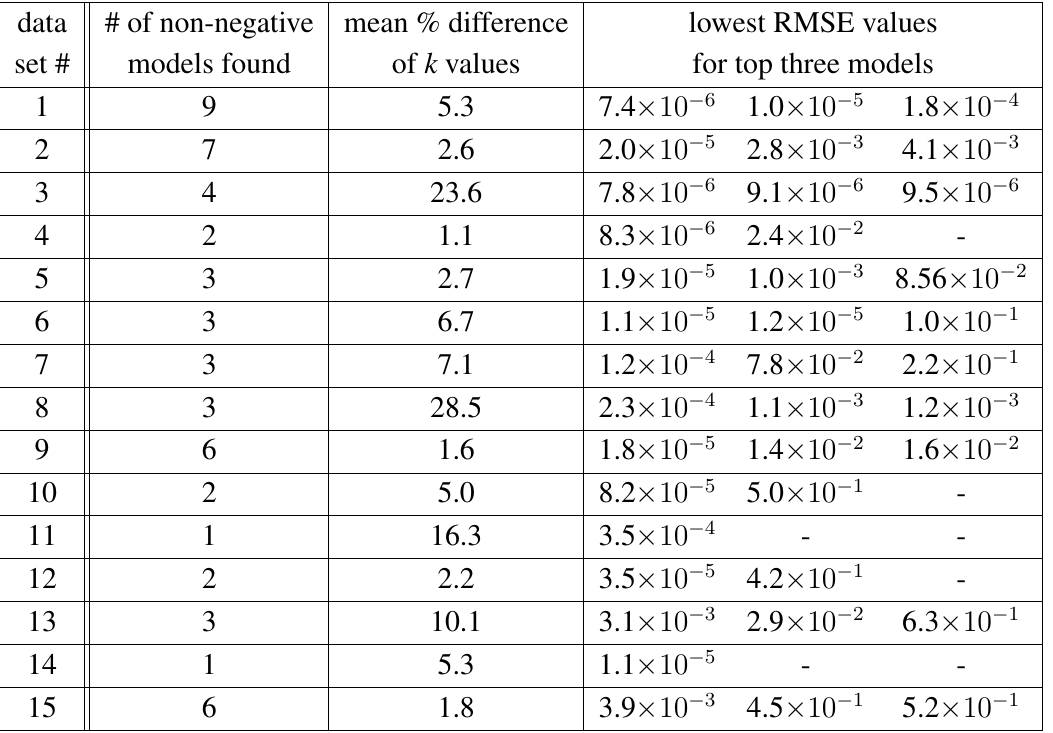
Table 1. RMSE errors for 15 different random data sets to determine accuracy and repro- ducibility on three intermediate